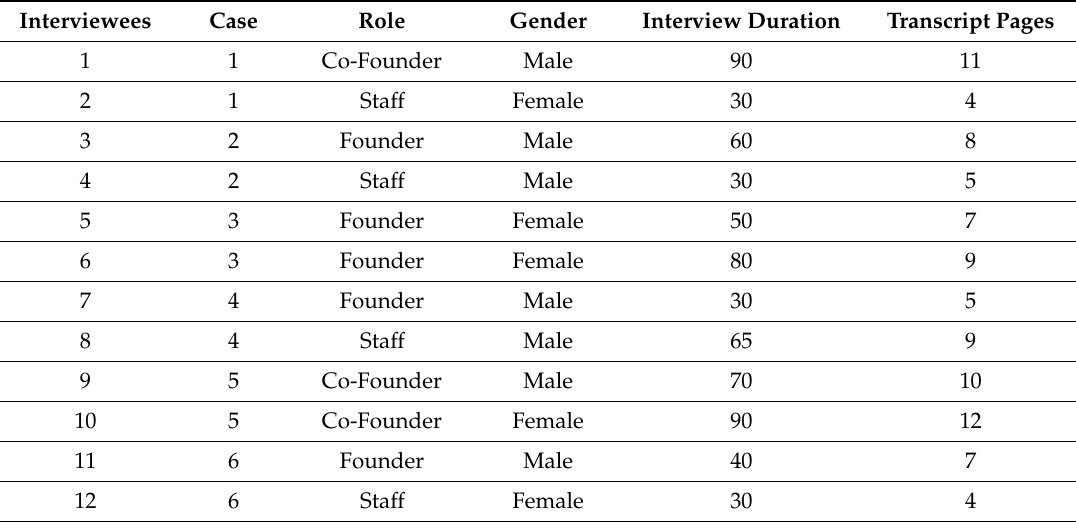
Table 4. Data collection from semi-structured interviews.